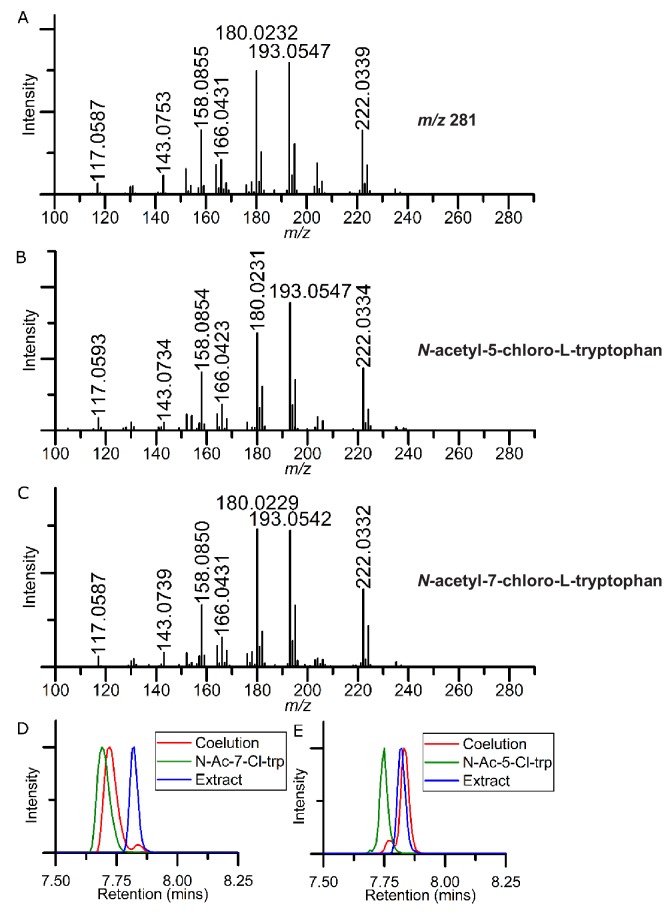
Comparison of unknown m/z 281 species to synthetic N-acetyl-5-chloro-L-tryptophan and N-acetyl-7-chloro-L-tryptophan.(A) Collision-induced (CID) fragmentation spectrum of m/z 281 from lsr2 mutant strain. (B) CID fragmentation spectrum of N-acetyl-7-chloro-L-tryptophan. (C) CID fragmentation spectrum of N-acetyl-5-chloro-L-tryptophan. (D) Coelution of m/z 281 extracted ion chromatograms of synthetic standard of N-acetyl-7-chloro-L-tryptophan, lsr2 extract, and coelution. (E) Coelution of m/z 281 extracted ion chromatograms of synthetic standard of N-acetyl-5-chloro-L-tryptophan, lsr2 extract, and coelution.